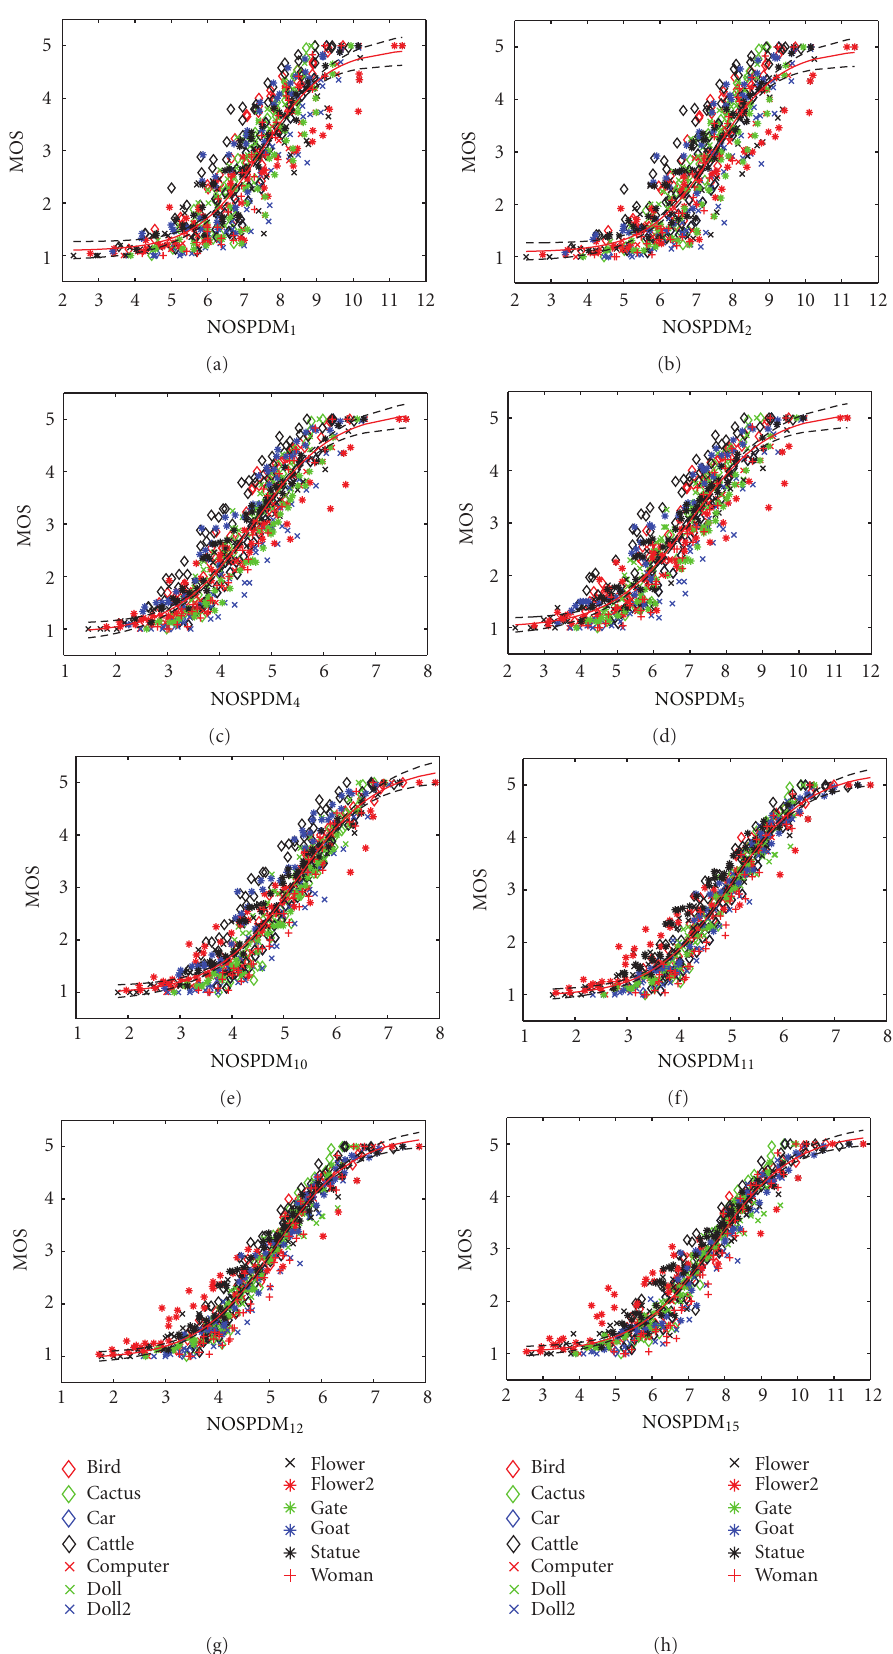
Figure 9: Scatter plots of MOS versus representive NOSPDM algorithms on the Toyama database [3]. The (red) lines are curves fitted with the logistic function and the (black) dash lines are 95% confidence